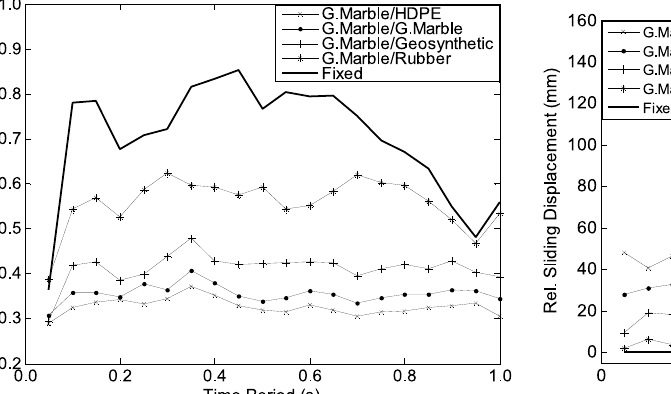
Fig. 10. Absolute acceleration spectra of the roof mass for fi xed and different sliding interfaces for spectrum compatible ground motion.